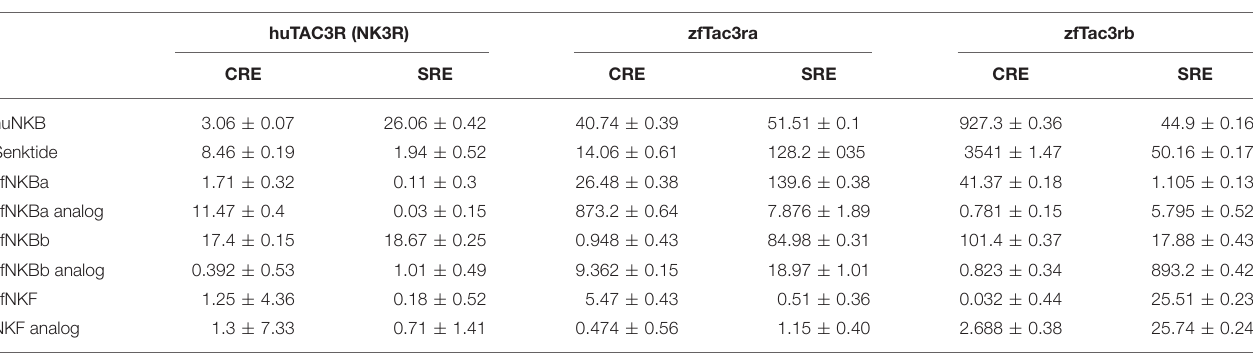
TABLE 3 | EC 50 values (nM) of human and zebrafish NKB